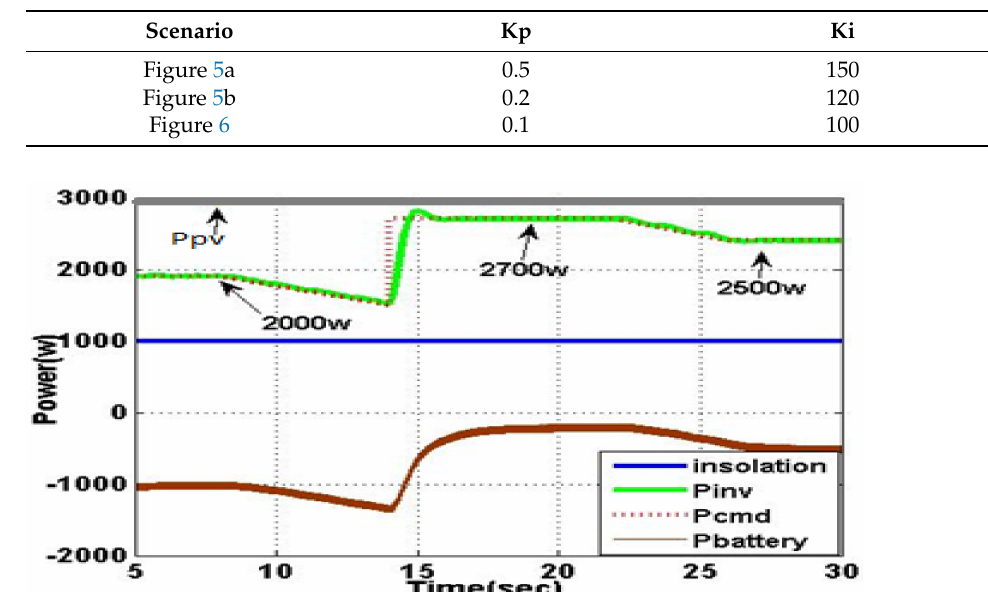
Figure 6. Operation of proposed system following real power